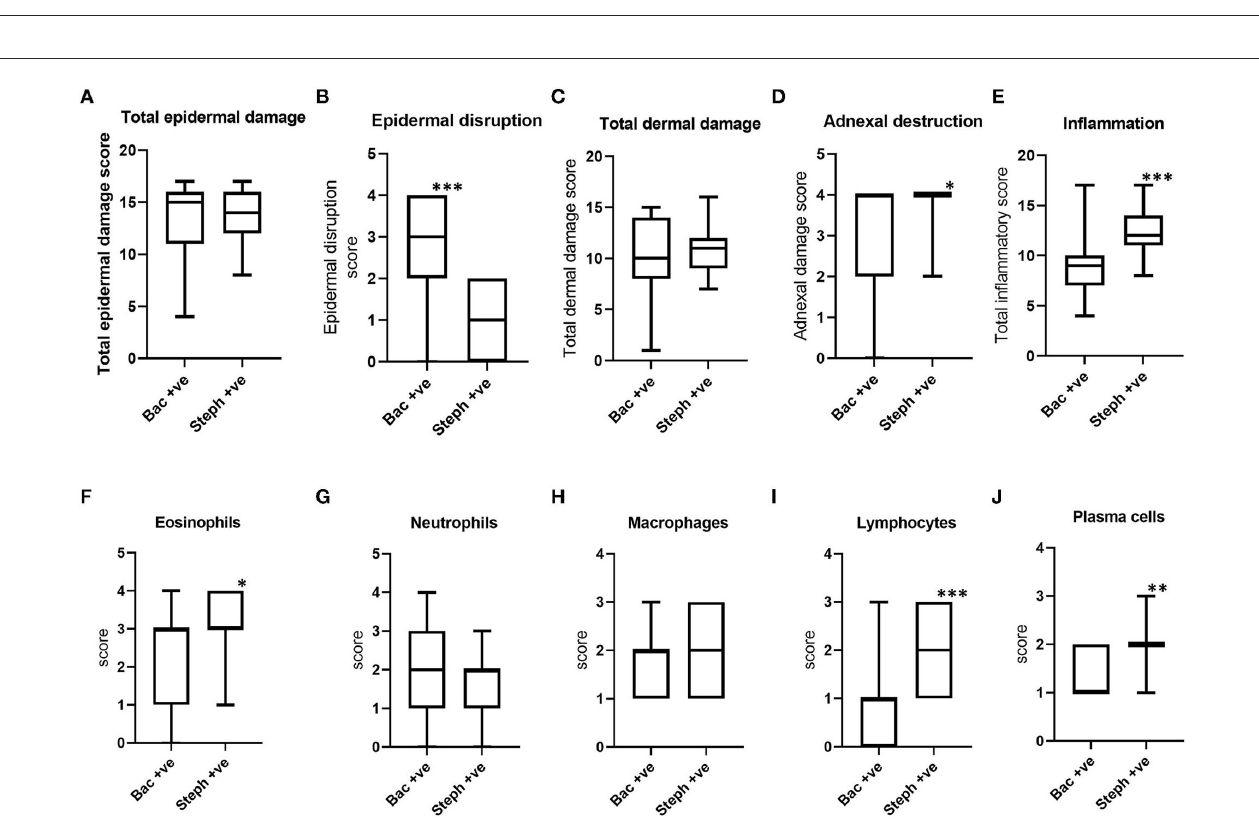
FIGURE7 Boxplots (A–D) indicating the distribution of scores for total epidermal damage, epidermal disruption, total dermal damage and adnexal destruction scores for bacterial positive lesions (Bac + ve) and Stephanofilaria positive lesions (Steph + ve). Boxplots (E–J) show total inflammation and individual inflammatory cell scores of these two groups (* P < 0.05, ** P < 0.01, *** P <